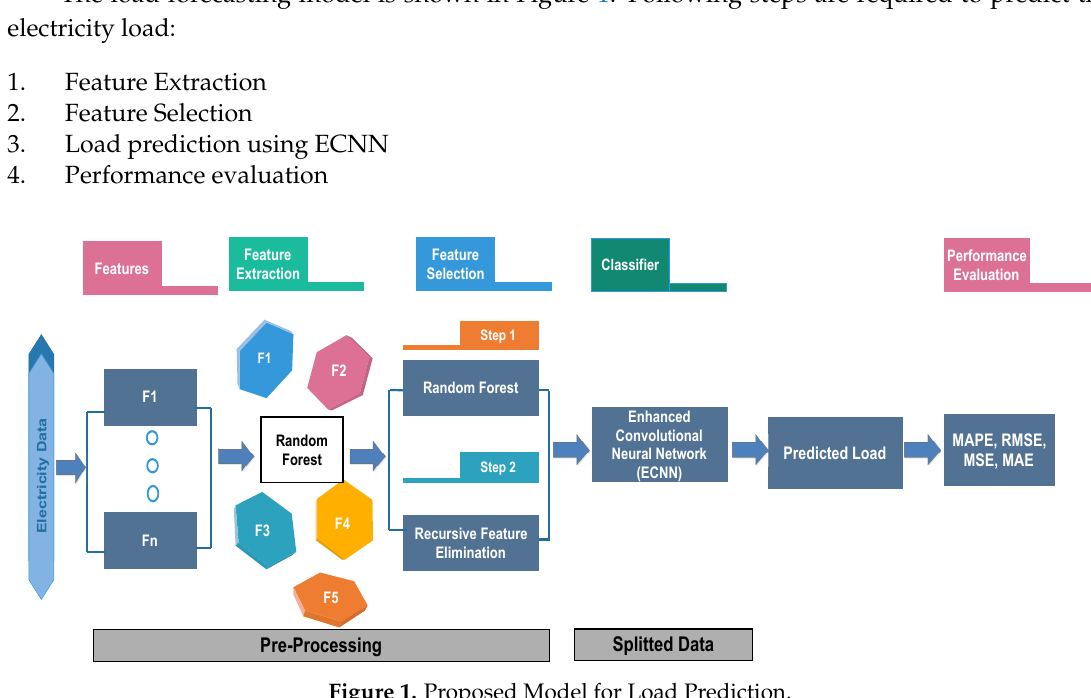
Figure 1. Proposed Model for Load